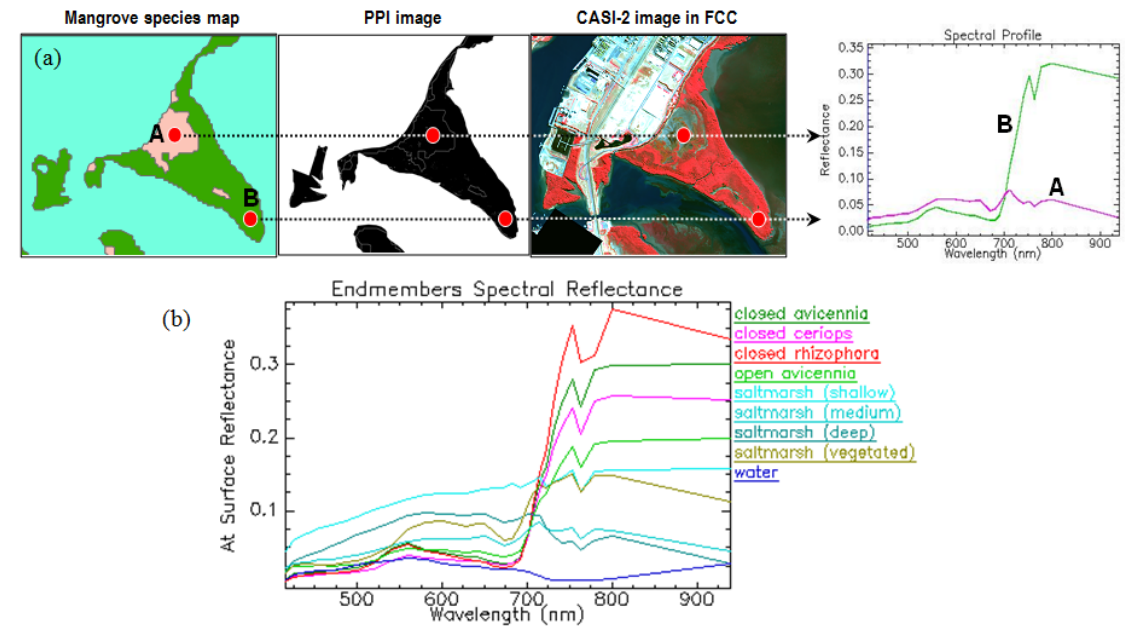
Figure 2. (a) Endmember selection strategy for pixel-based classification. Each image objects’ spectral reflectance was derived from known-associated objects in the map, pixel purity image (PPI) image, and false-color composite (FCC) image. Object code: A is saltmarsh and B is closed Avicennia . (b) The spectral reflectance of the nine-collected endmembers in different color